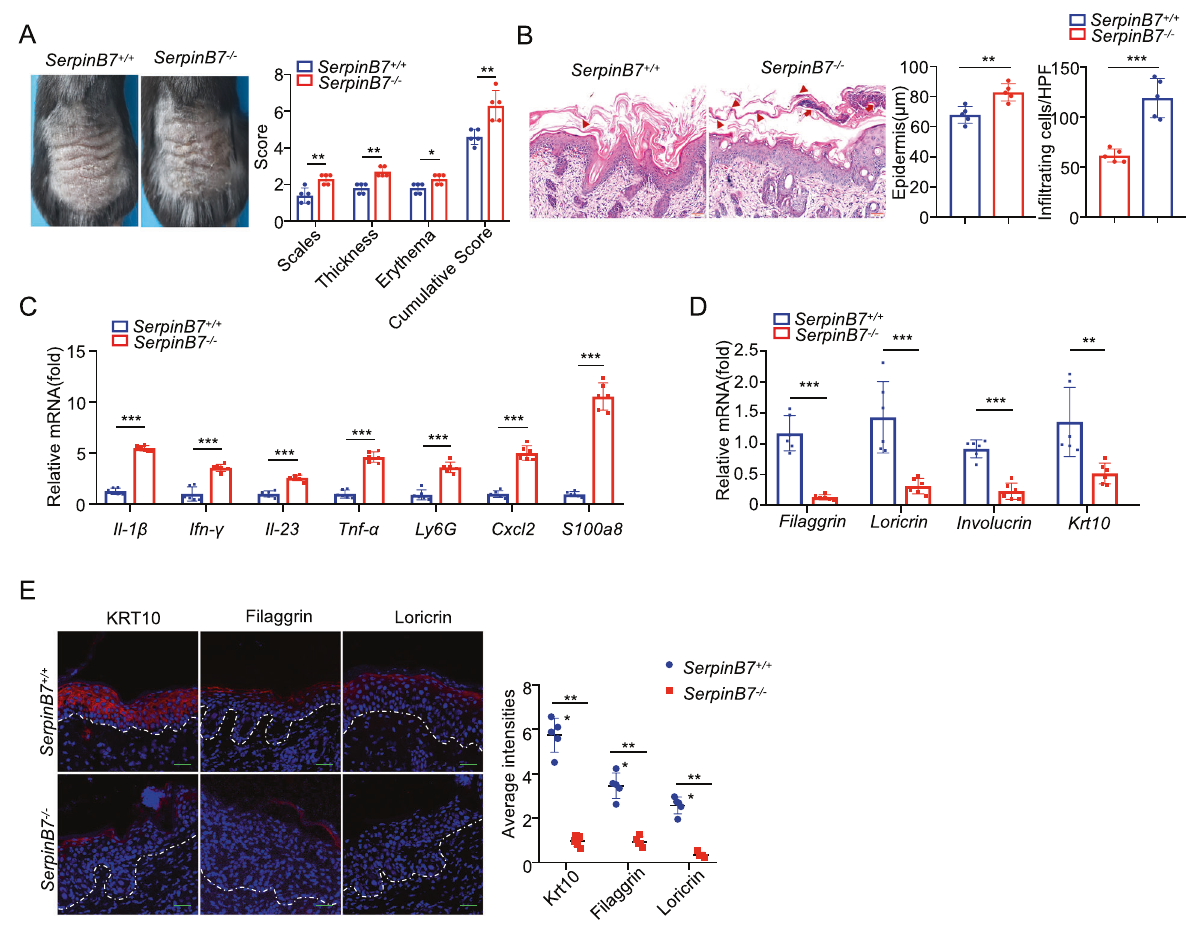
Fig. 3 Ablation of SerpinB7 leads to exacerbation of IMQ-induced Psoriasis model. A SerpinB7 + / + and SerpinB7 -/- mice were treated with IMQ for 5 days, n = 5/group. Representative images of the dorsal skin from mice (left) and mice PASI scores were depicted (right). B Representative H&E staining section from the skin tissues of SerpinB7 + / + ( n = 5) and SerpinB7 -/- ( n = 5) mice. Parakeratosis is indicated by the triangle, Munro ’ s microabscess is indicated by the arrows. Right: statistical analysis of skin epidermal thickness and in fl ammatory cell in fi ltration. C The RNA levels of keratinocytes differentiation-related genes were assessed by qPCR. D The RNA levels of chemokines and antimicrobial peptides were assessed by qPCR. E Immuno fl uorescent staining of Krt10, Filaggrin, and Loricrin in the dorsal skin of SerpinB7 + / + ( n = 5) and Serpinb7 -/- ( n = 5) mice. Right: statistical analysis of staining intensity in the epidermis. Mean ± SD. * P < 0.05; ** P < 0.01; *** P < 0.001. Two-tailed Student ’ s t -test ( A – E ). All the data are representative of three independent